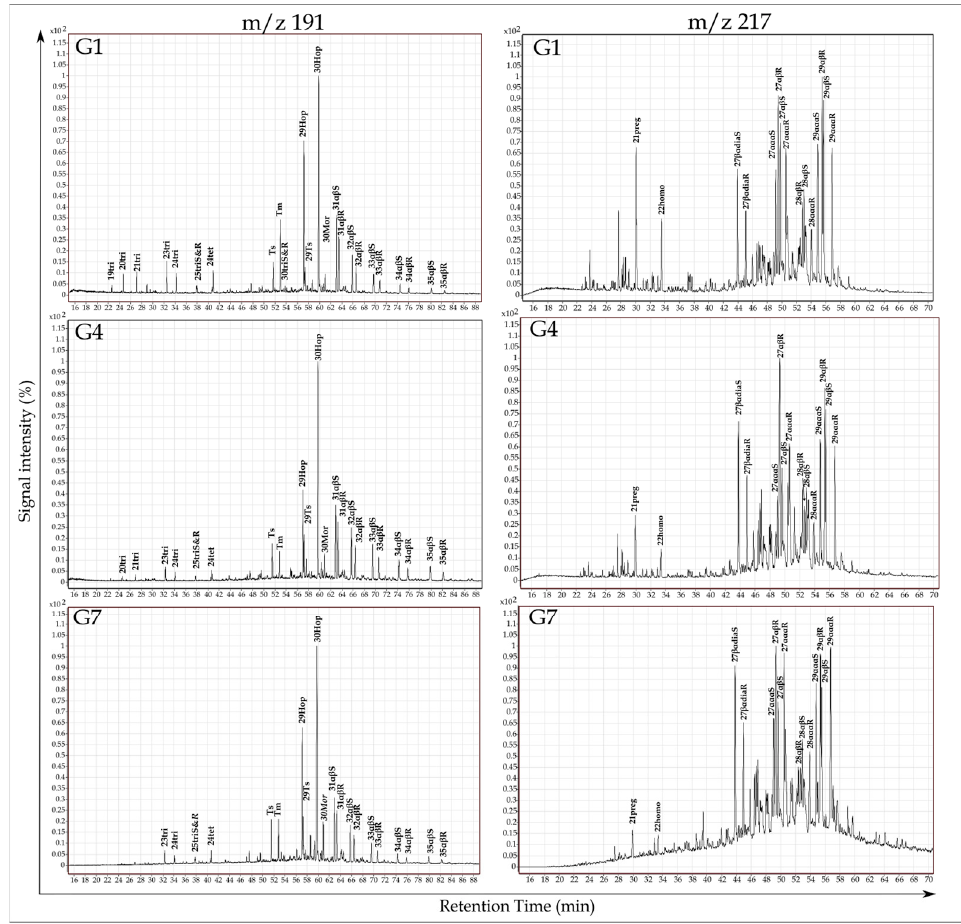
Figure 3. GC-MS chromatograms of the ions m / z 217 and m / z 191 for the samples G1, G4 and G7. For the m / z 217, the biomarkers are as follows: 21Preg, C21-5 α (H) sterane;